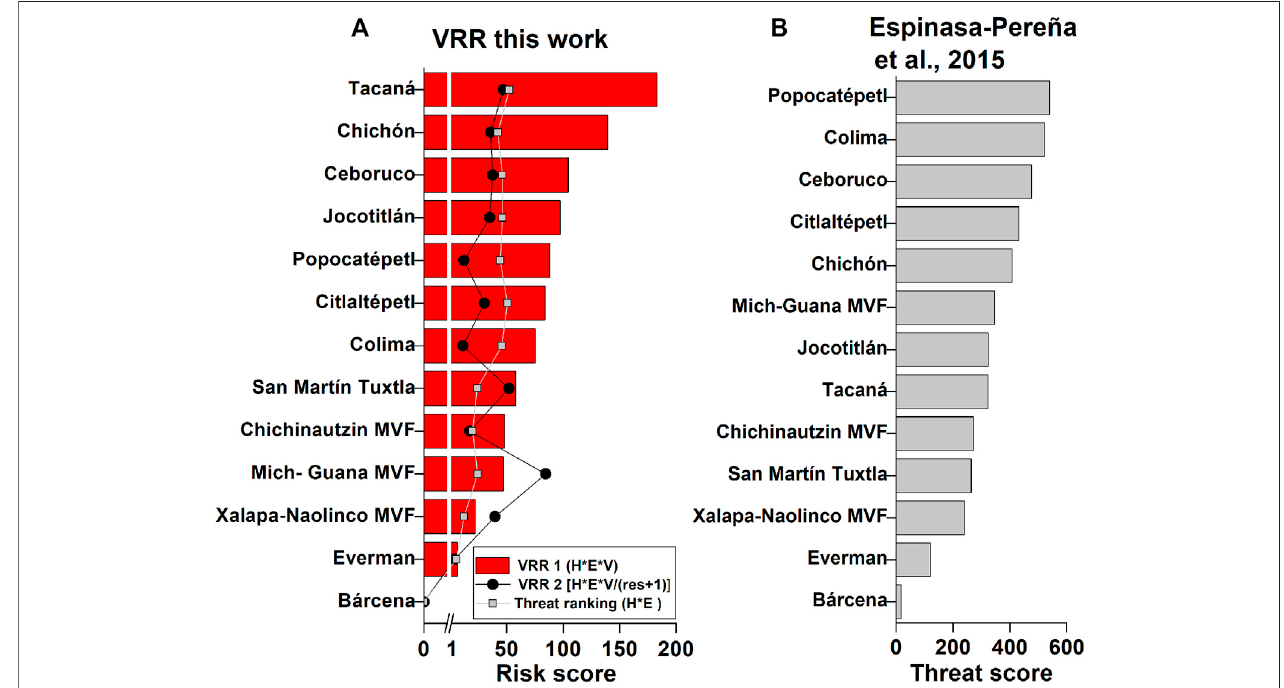
FIGURE5|(A) VRR(1) (redhistograms) and VRR(2) (black circles) ofMexican volcanoeshaving erupted < 1 ka(graysquaresindicate thethreat ranking).Thescale between 0 and 1 has been increased (and indicated by a white vertical line) in order to better visualize risk scores < 1. (B) Volcanic threat ranking for volcanoes having erupted < 1 ka from Espinasa-Pereñaet al.(2015)using Ewertet al.(2005) approach (onlybased onhazardand exposure). Tonotethat thescoreofBárcena isnotzero in the case of the threat assessmentof Espinasa-Pereña, as in their case they had considered acertainvalue ofexposure due to a small settlementthat is no more